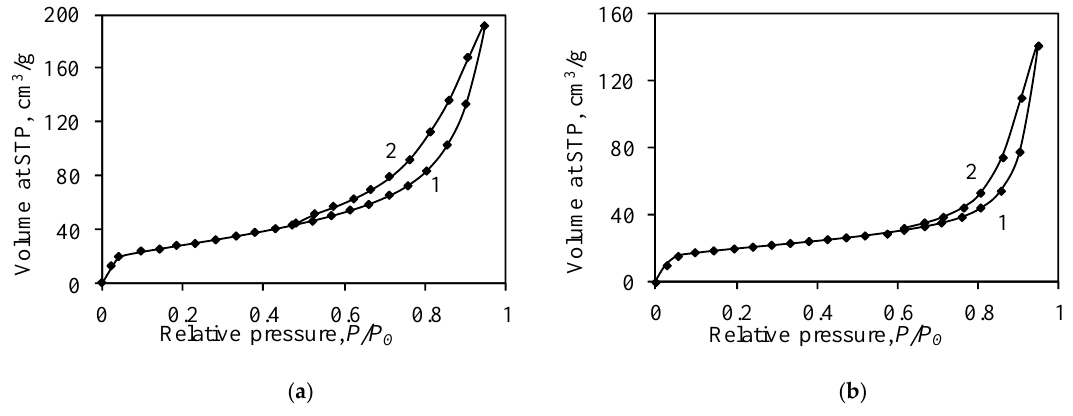
Figure 4. Adsorption (1) – desorption (2) isotherms of synthetic ( a ) and calcined ( b ) samples.